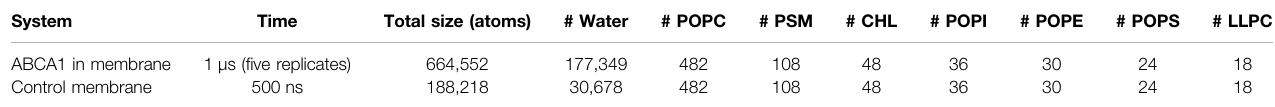
TABLE 1 | Simulation details of the